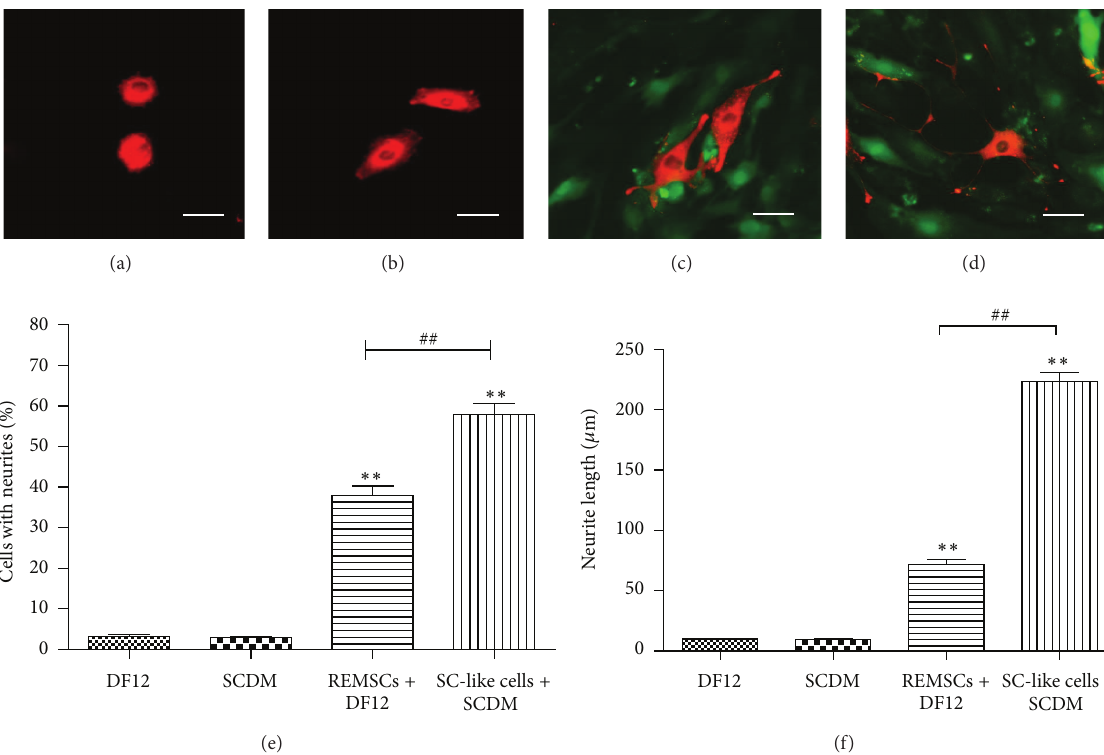
Figure 5: Neurite outgrowth by PC12 cells was observed in different conditions. PC12 cells were labelled by CM-Dil (red) and SC-like cells or REMSCs were infected with GFP virus (green). (a) PC12 cells were cultured alone in DF12 medium. (b) PC12 cells were cultured in SCDM alone. (c) PC12 cells were cocultured with REMSCs in DF12 medium. (d) PC12 cells were cocultured with SC-like cells in SCDM. PC12 cells with few neurites in (a) and (b) were round red. PC12 cells with neurites were observed in (c) and (d), and the cells in (d) showed morphological phenotype of mature neuron. The percentage of cells with neurites (e) and the length of neurites (f) were shown in the two bar graphs, respectively. Data were presented as mean ± SEM from three independent experiments. ∗∗ 𝑃 < 0.01 represent significant differences compared between group C or group D and group A; ## 𝑃 < 0.01 represent significant differences compared between groups C and D. Bar: 50 𝜇 m for all